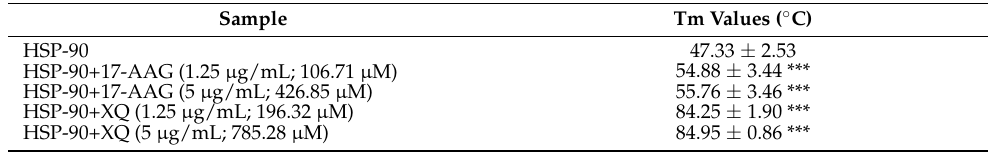
Figure 9. Melting profile of HSP-90. Melting profile of HSP-90 (1 µ g) with different doses of ( a ) xestoquinone (XQ) and ( b ) 17-AAG. The upper figures show the thermal denaturation profiles of HSP-90 proteins with XQ or 17-AAG, respectively. The lower figures show the profiles of the deriv-ative of fluorescence emission as a function of temperature (dF/dT) in HSP-90 treated with XQ or 17-AAG, respectively. Table 2. Melting temperature (Tm) of HSP-90 in the presence of 17-AAG and